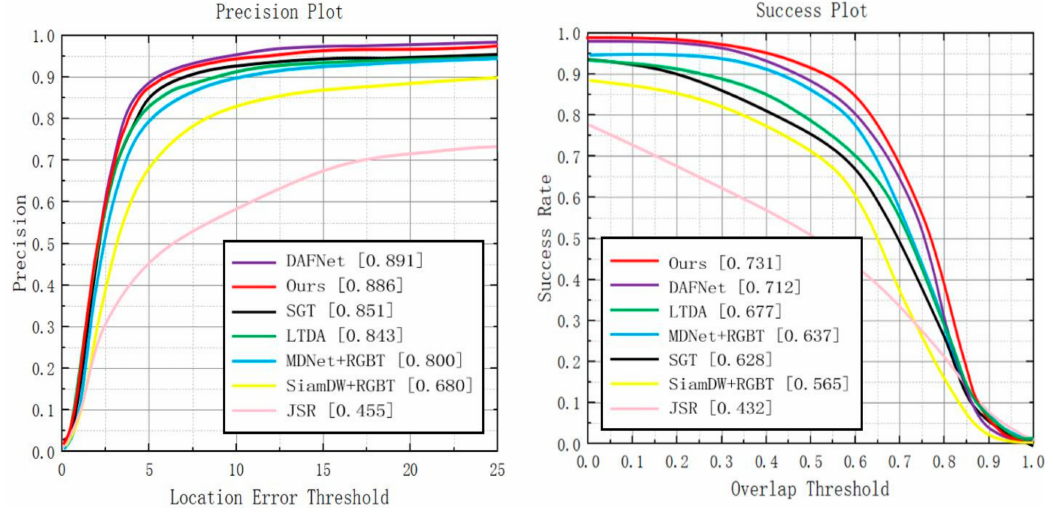
Figure 6. Comparison results with the current state-of-the-art methods on